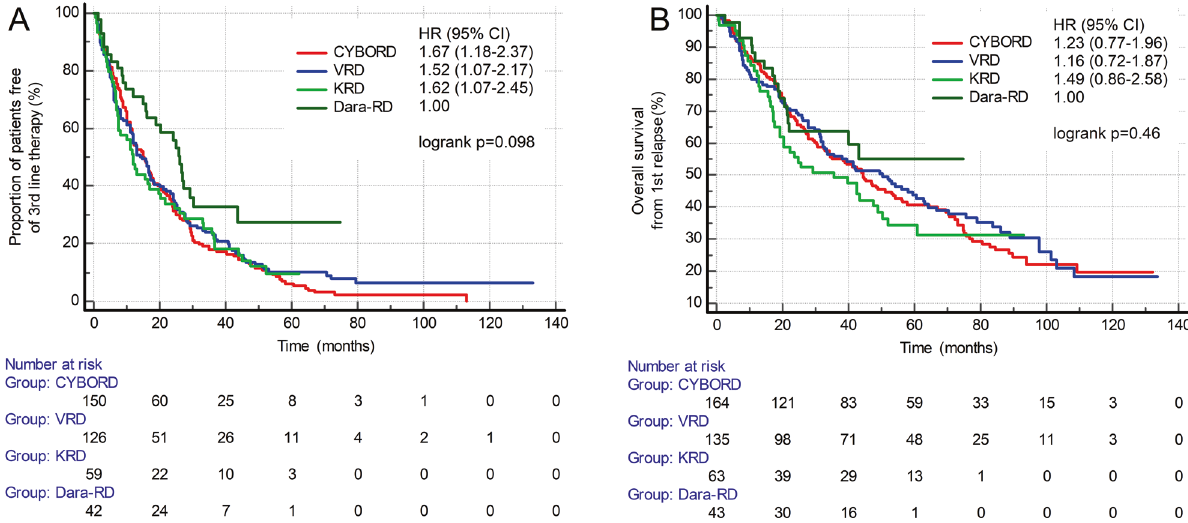
Fig. 5 Comparisons of most frequently used triplet regimens on post-progression survival. A Time to next treatment from fi rst relapse (TTNT). B Overall survival from fi rst relapse (OS). CI con fi dence interval, CYBORD cyclophosphamide-bortezomib-dexamethasone, Dara-RD daratumumab-lenaliodmide-dexamethasone, HR hazard ratio, KRD car fi lzomib-lenalidomide-dexamethasone, VRD bortezomib-lenalidomide- dexamethasone.